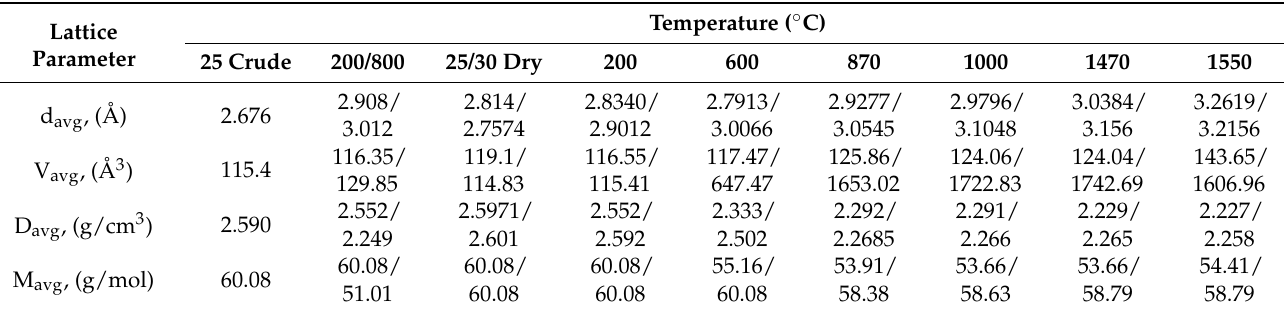
Table 4. Quartzite crystal lattice parameters for different moisture